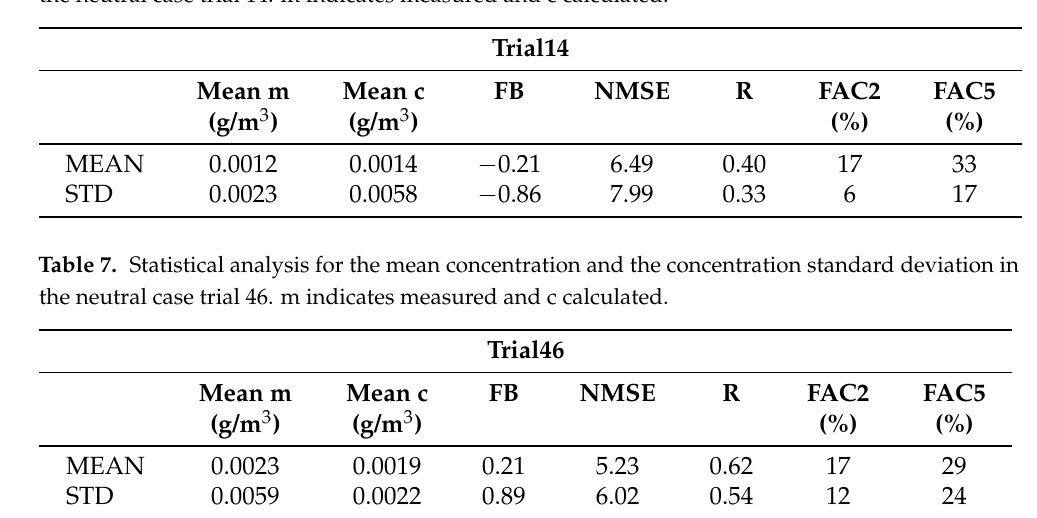
Table 6. Statistical analysis for the mean concentration and the concentration standard deviation in the neutral case trial 14. m indicates measured and c calculated.